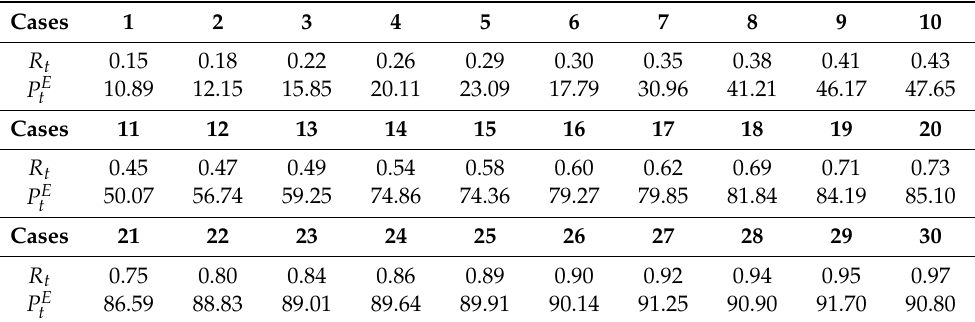
Table 3. R t and P E of the 30 cases of water rights t